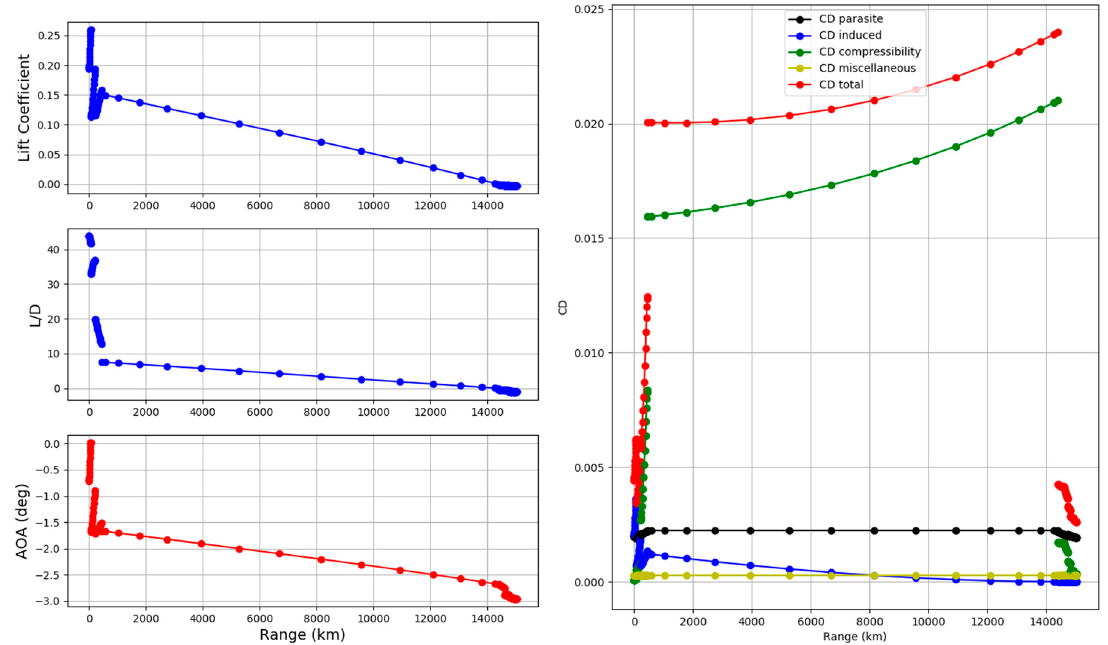
Figure A7. Aerodynamic performance of SE²A-LR calculated using SUAVE for higher-fidelity analysis.